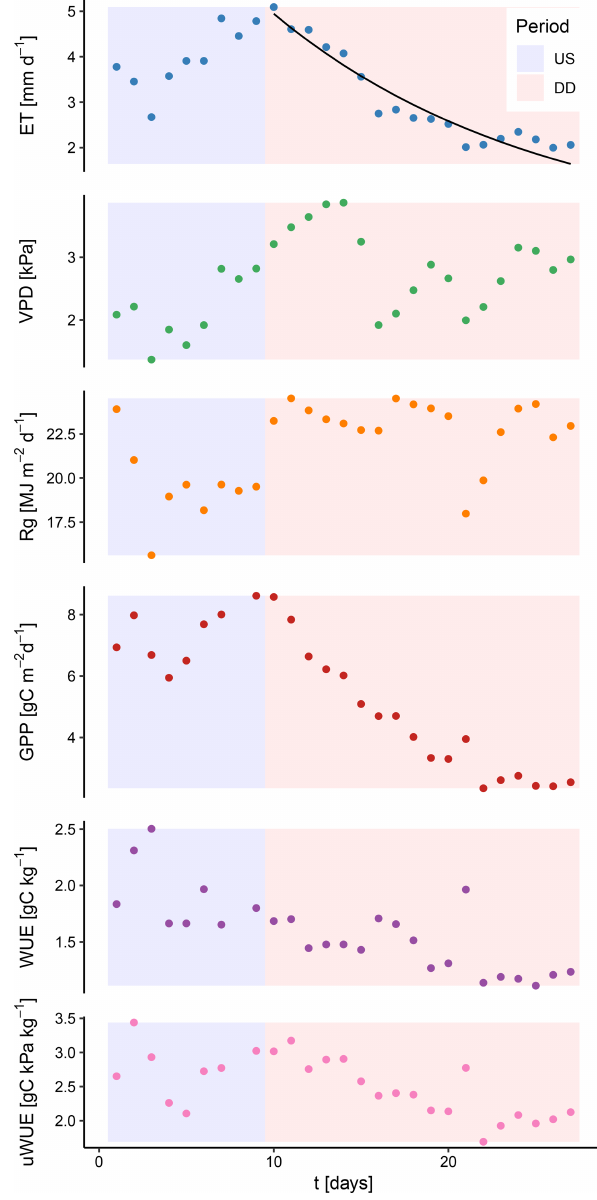
Figure 2. Temporal behavior of relevant ecosystem variables dur- ing an unstressed period (US) and a dry-down event (DD) at the FLUXNET site US-Arc. While ET and GPP show a distinct and ex- ponential decay during the dry-down event, the variables reflecting the atmospheric demand (solar radiation, R g , and the vapor pressure deficit, VPD) remain high. The black line denotes an exponential fit to the decreasing